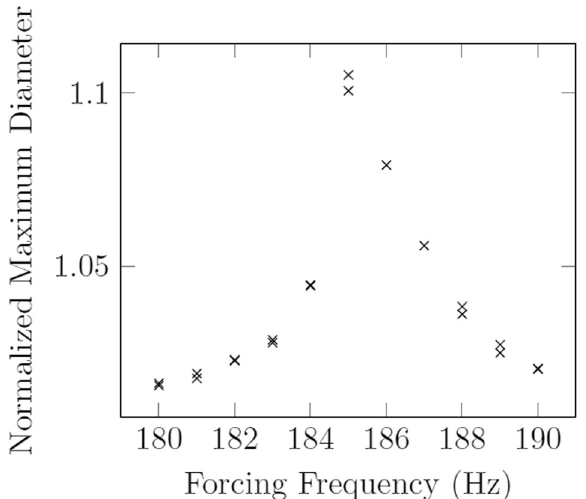
Fig. 1 The Faraday forcing method using the normalized maximum diameter of the oscillating sample (from Brosius et al. 15 ). Sample is 35.027 mg Zirconium at 1800 ∘ C.